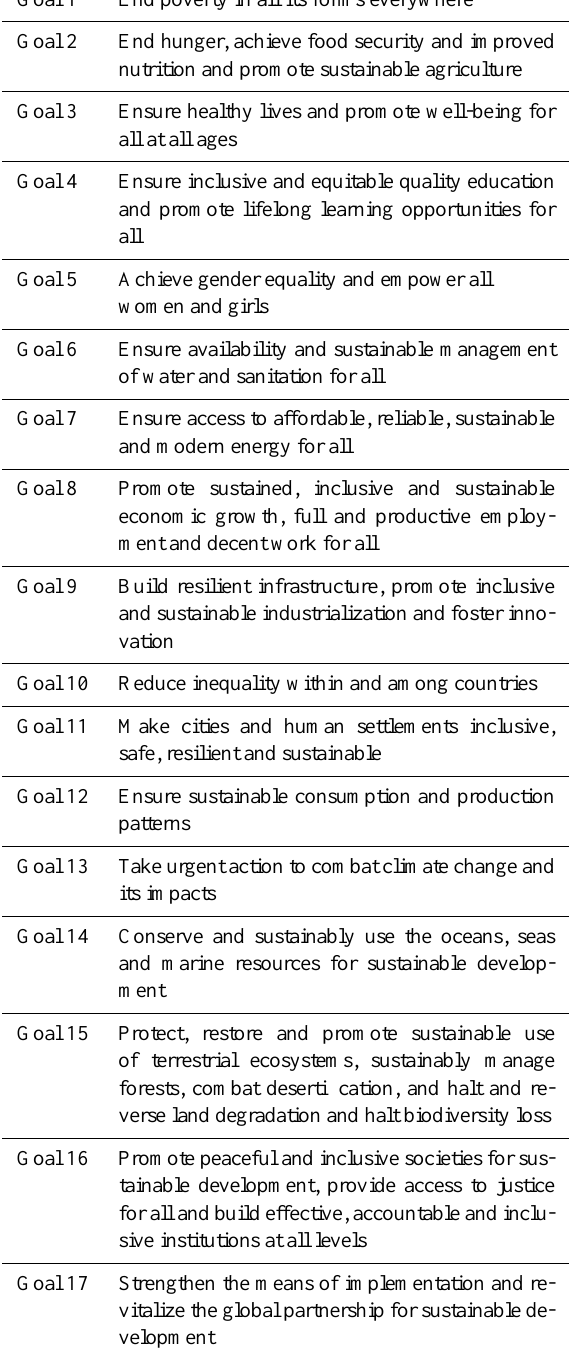
Table 2. Ecosystem services with an important soil component ac- cording to Dominati et al.